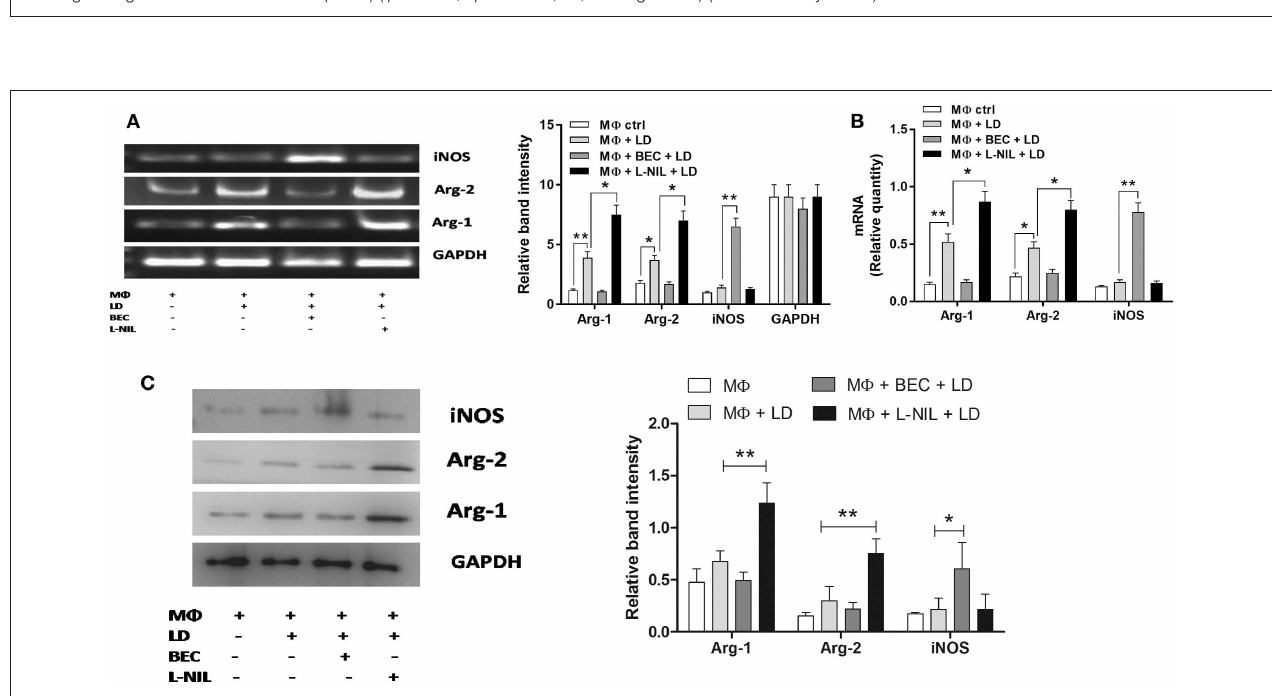
FIGURE 7 | Regulation of Arg-1, Arg-2, and inducible nitric oxide synthase (iNOS) expression in case of Leishmania donovani infection. THP-1 monocyte-derived M Φ s (1 × 10 6 cells/ml) were either left untreated or preincubated with BEC (200 µ M) or L-NIL (100ng/ml) for 3h followed by infection with L. donovani for 48h (A–C) . The expression of Arg-1, Arg-2, and iNOS was determined at the transcript level by semi-quantitative RT-PCR (A) and real-time PCR (B) and protein level by western blotting (C) . The intensity of the bands was quantified by densitometry using Quantity one software. Each experiment was repeated three times. Each determination was made in triplicate and the values were expressed as mean ± SD for three independent experiments. Semi-QRT PCR gel images and western blots are representative of three experiments. Densitometric plots are shown adjacent to the gel images. Kruskal–Wallis with Dunn’s multiple comparison test was used to evaluate statistical significance for comparing three or more groups; * p < 0.05; ** p < 0.005.